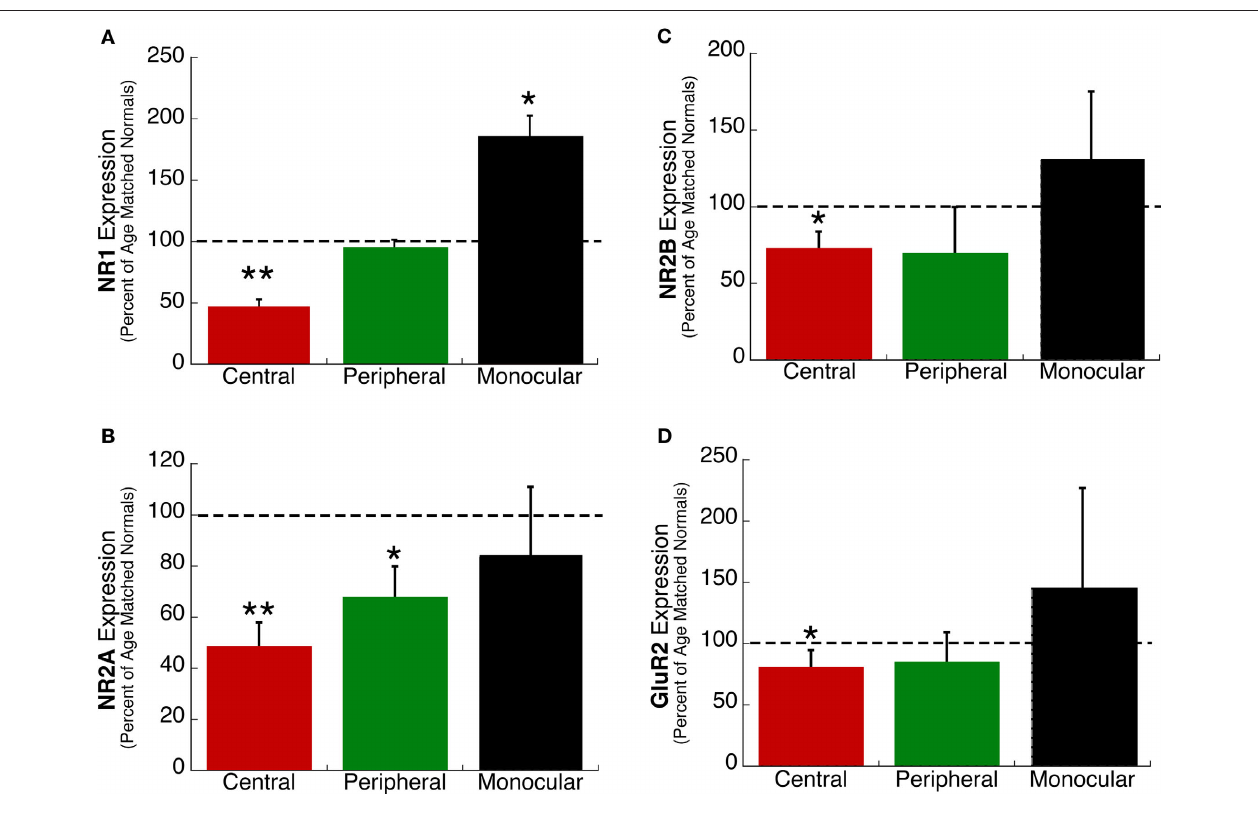
was measured as a percent of age matched normal kittens for each region of visual cortex. Dashed lines represent the relative expression in normally reared kittens. Significant differences are indicated (* p < 0.05; ** p <